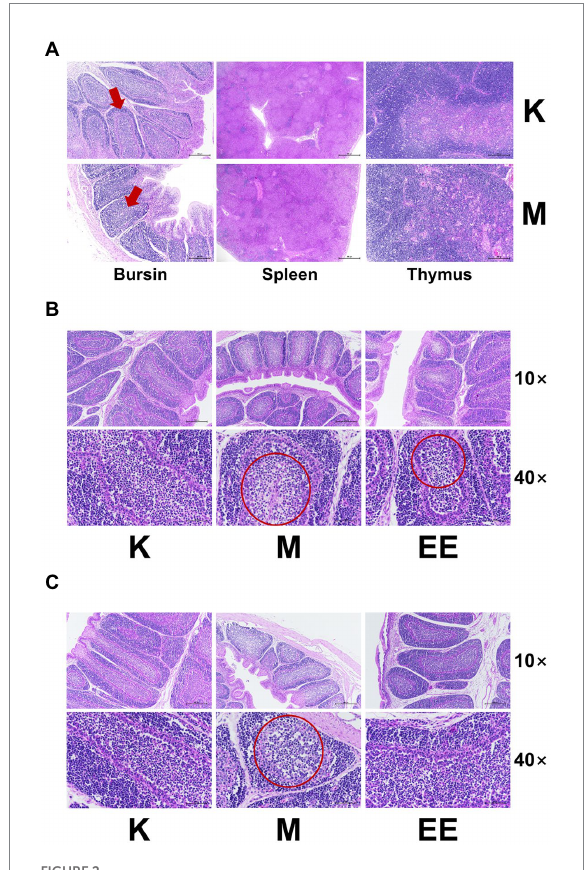
FIGURE 2 Effect of Echinacea on histopathology of immune organs (HE staining). (A) Pathological changes of immune organs after 7 days of immunosuppression. The area indicated by the red arrow shows a poorly demarcated bursal skin medulla; (B) Pathological changes of bursa of each group after 7 days of treatment; (C) Pathological changes of bursa of each group after 14 days of treatment. In the area circled by the red circle, the cells are less aggregated and sparser and the number of lymphocytes is reduced. ( N =